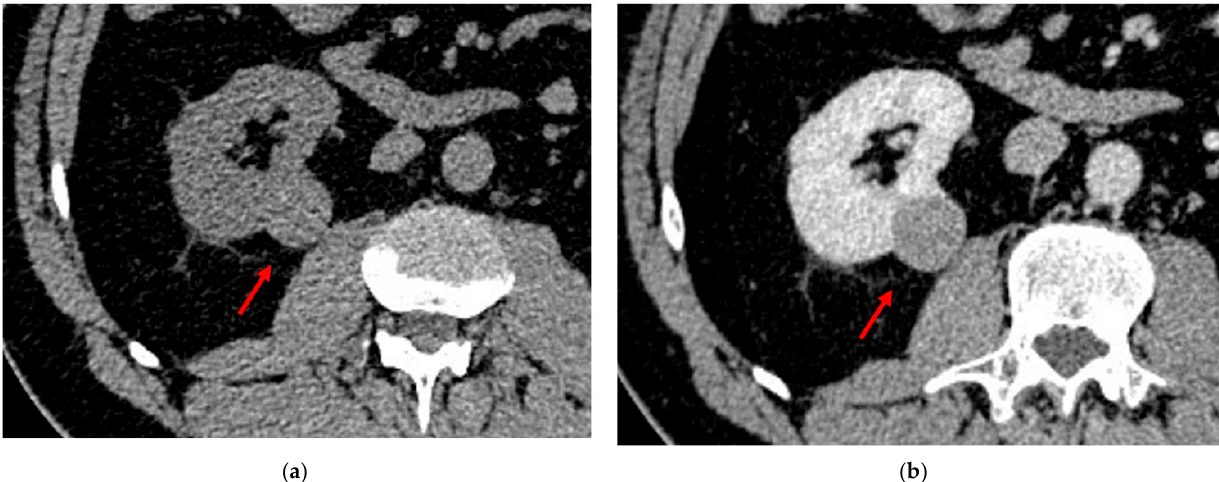
Figure 5. Abdominal CECT of pRCC demonstrate a cortical small renal lesion. ( a ) In a pre- contrastographic phase, the formation is isodense with the adjacent renal parenchyma. ( b ) The same lesion progressively enhances homogeneously, but due to the hypovascular nature, shows overall hypoenhancement compared to the adjacent normal renal cortex.